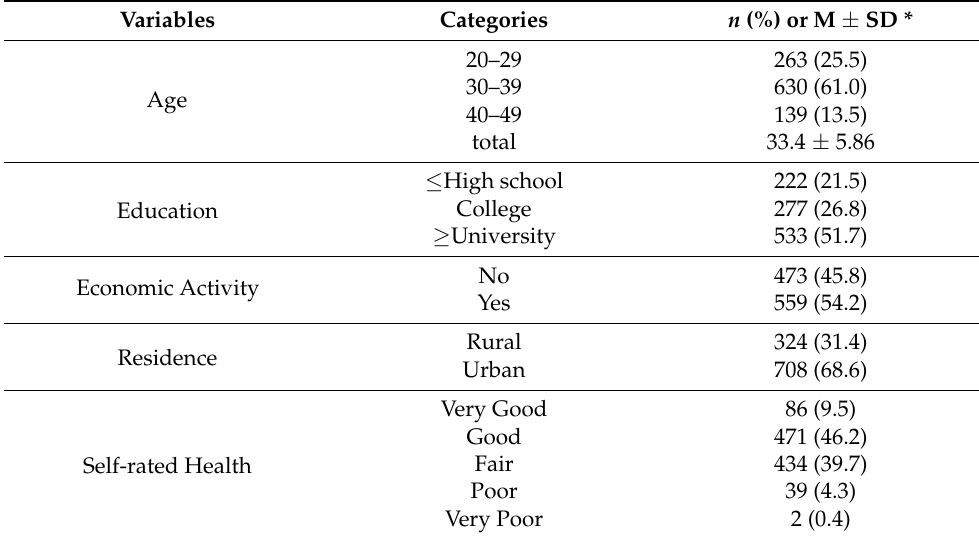
Table 1. Demographic characteristics of pregnant women ( n =